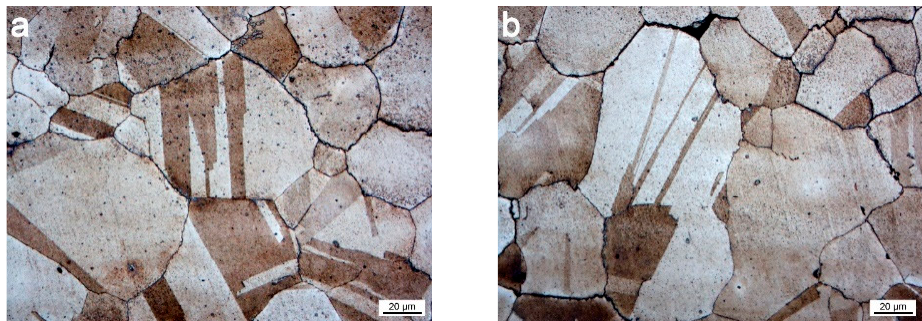
Figure 7. Reobservation of the etched sample after three months. ( a ) Corresponds to the same region as Figure 6c; ( b ) corresponds to the same region as Figure 6d.